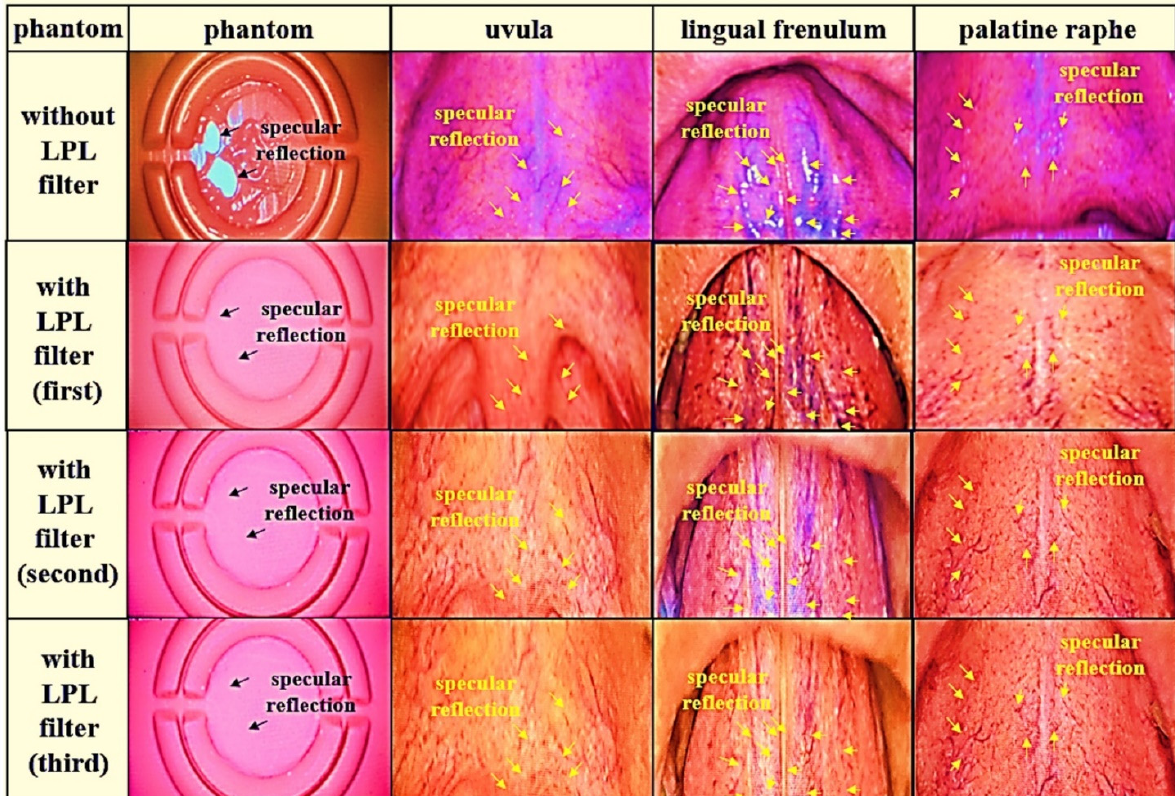
Figure 11. Experimental results of removal specular reflection through oral imaging.